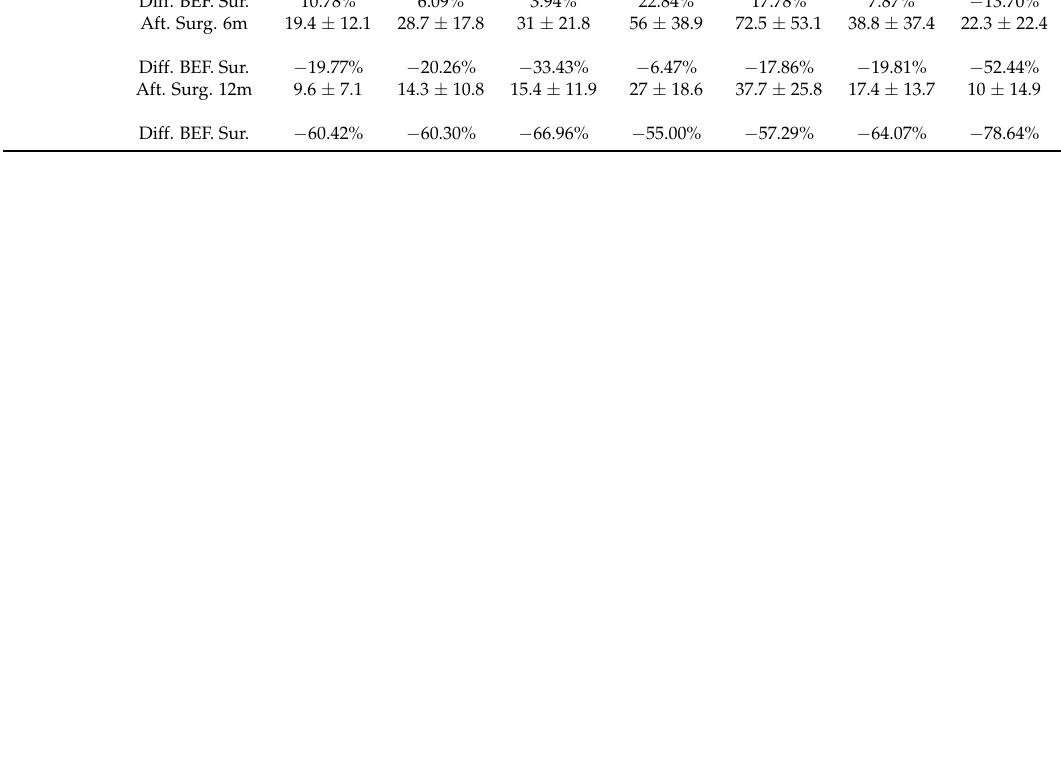
Table 2. Object average data of anterior cruciate ligament between the control and experimental groups. Bands (Hz) Control group Experimental Bef. group